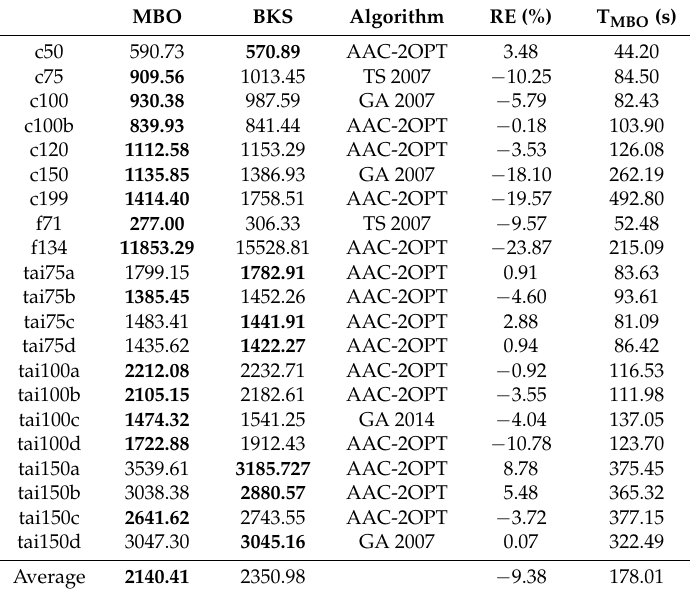
Table 2. Comparison of the average MBO results with the hitherto best known